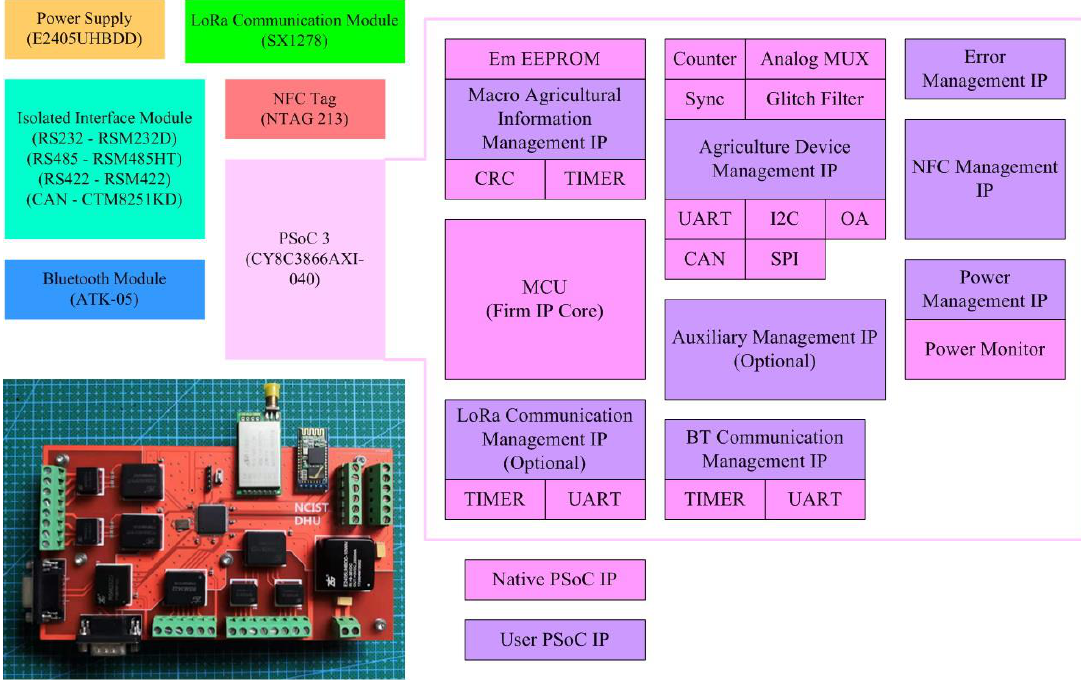
Figure 5. Hardware structure of in-field service node.